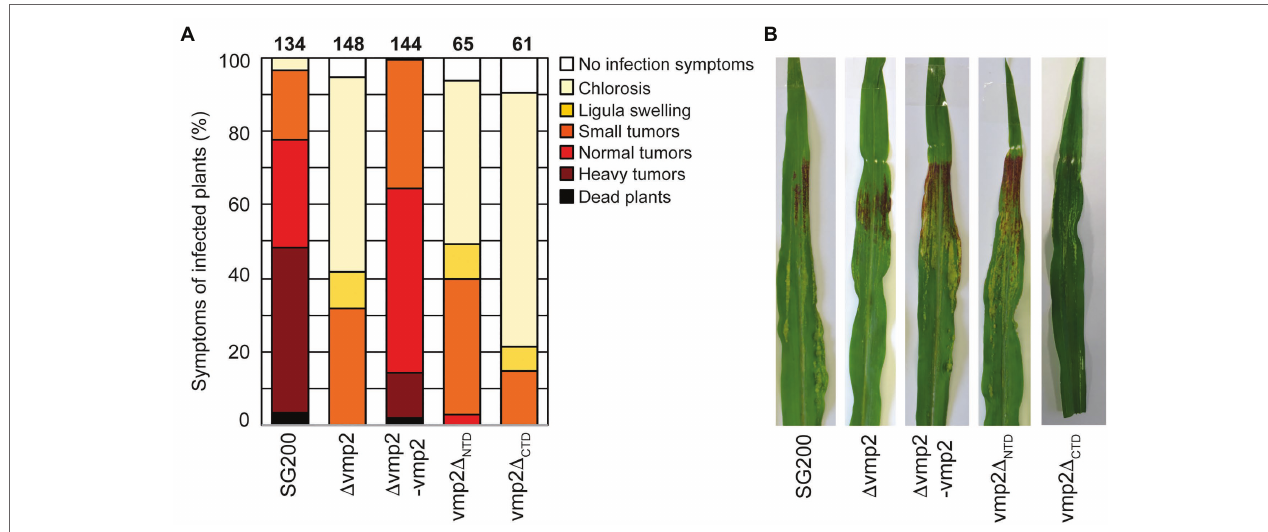
FIGURE 4 | Vmp2 is required for virulence (A) Virulence assay of the SG200 Δ vmp2 mutant strain and SG200 Δ vmp2-vmp2 complementation strain in U. maydis SG200 background. Disease symptoms were quantified based on three biological replicates. The number of infected plants is indicated above the bars. (B) Macroscopic pictures of maize leaves infected by U. maydis SG200, SG200 Δ vmp2, and SG200 Δ vmp2-vmp2 at 12